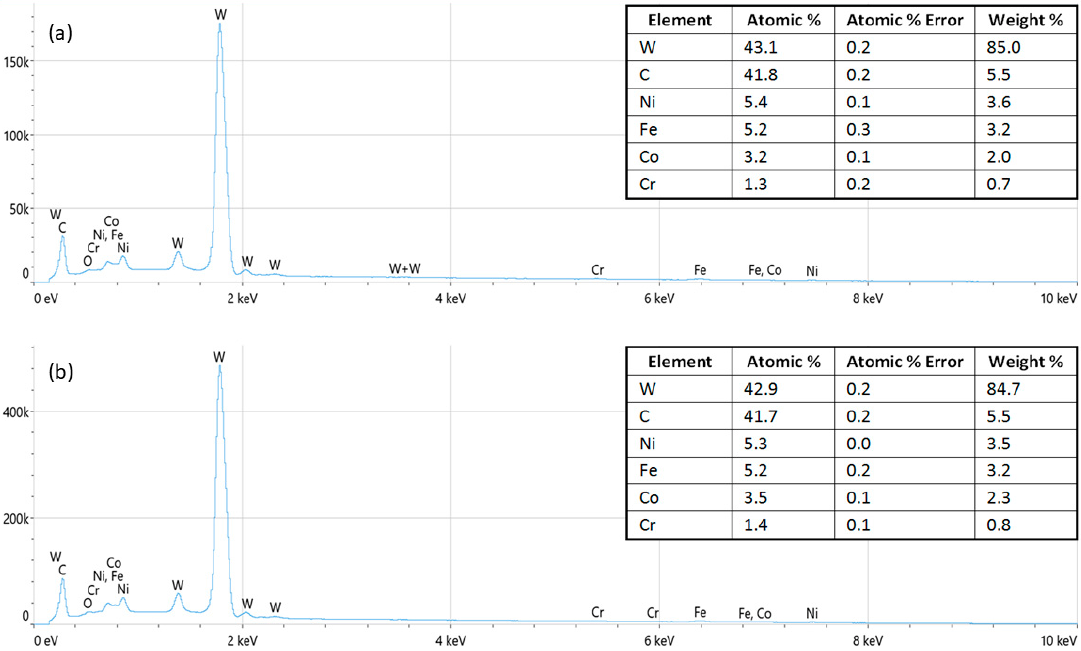
Figure 2. EDS spectra of the WC–9FeNi–1Cr 3 C 2 –0.5NbC sample ( a ) before and ( b ) after the corrosion process.